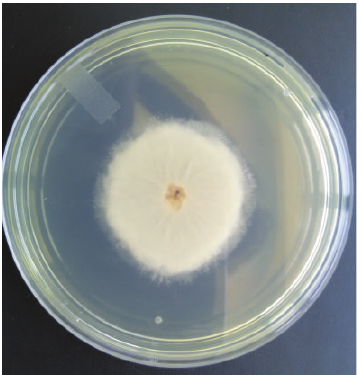
Figure 3: Growth on SDA within 48 hours at 30 ∘ C.